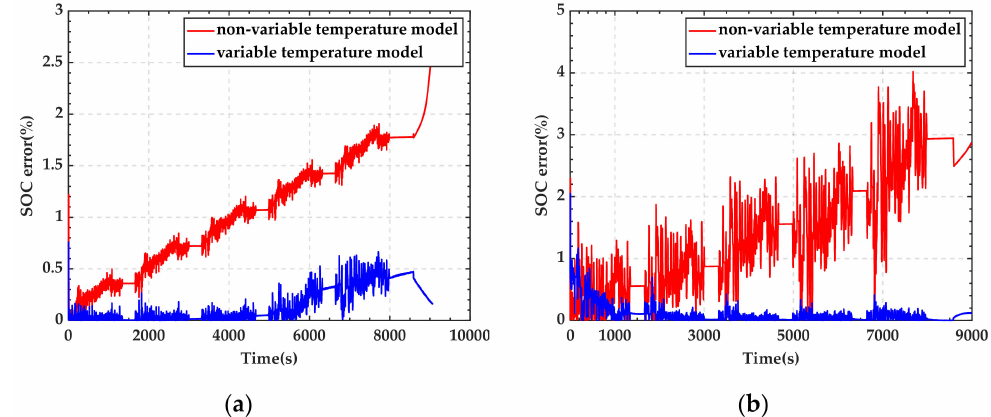
Figure 7. The SOC estimation errors with variable and non-variable temperature model at − 10 ◦ C and 40 ◦ C: ( a ) SOC estimation errors at − 10 ◦ C; ( b ) SOC estimation errors at 40 ◦ C.